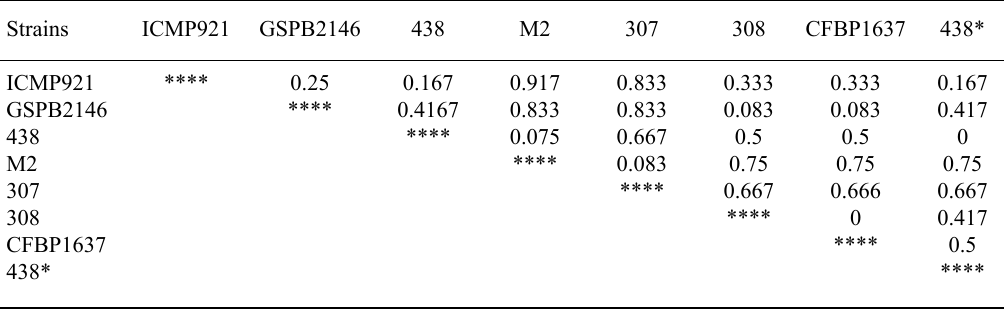
table 4. Dissimilarity index obtained with Pac I